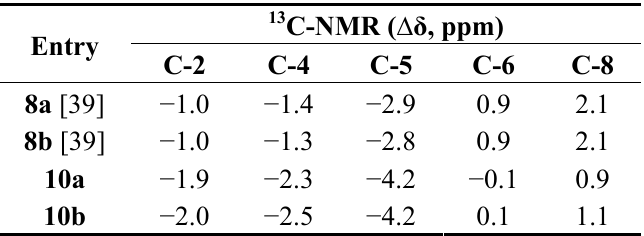
− δ , ppm). complex ligand